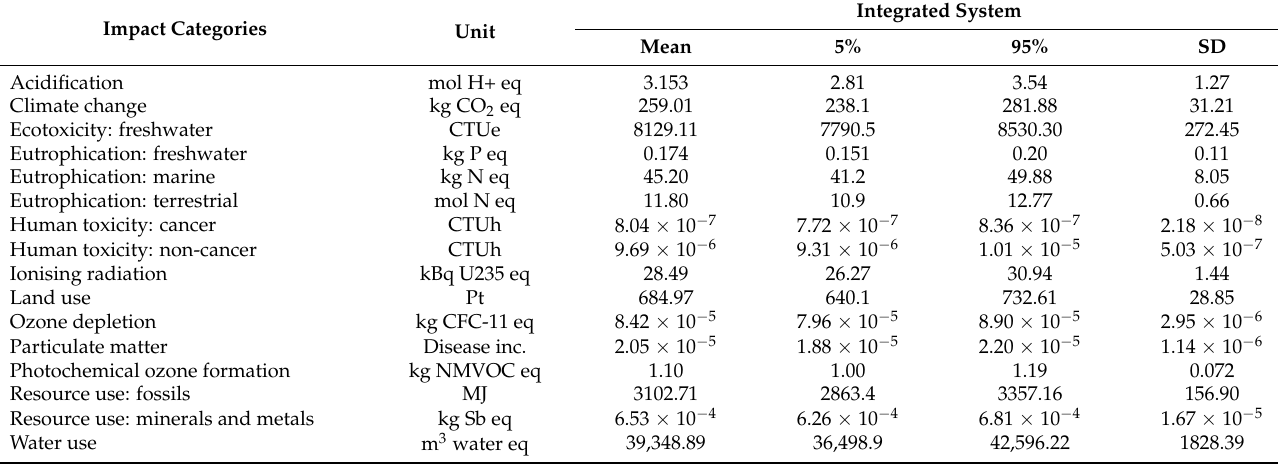
Table A4. Results of Monte Carlo simulation for 1 ton of table grapes at the farm gate with integrated (groundwater + reclaimed water)